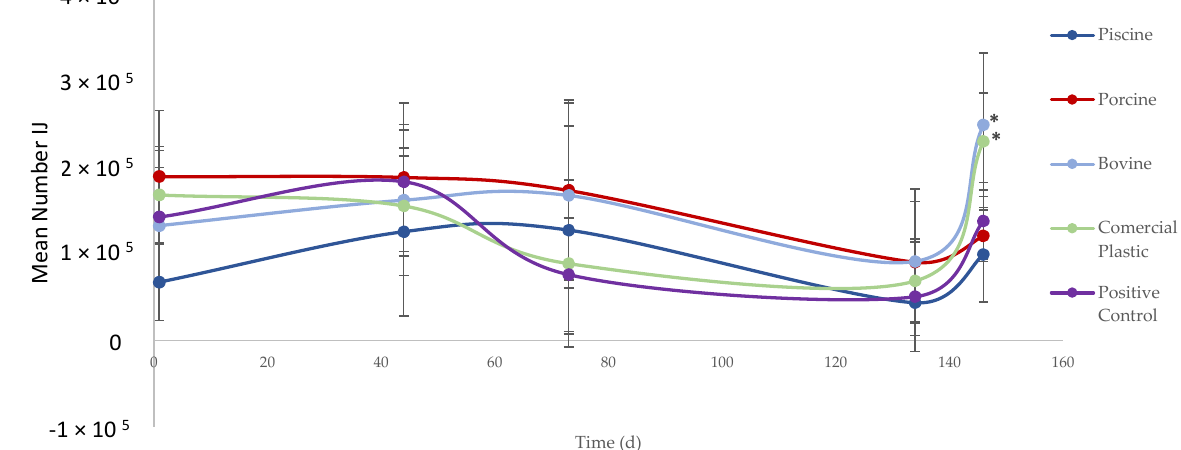
Figure 4. S. feltiae (SB12) reproduction rate in various bioplastic treated microcosms at five-time sampling points. Mean number of IJ recovered per 1.8 g of waxworms (n = 6, error bars represent standard